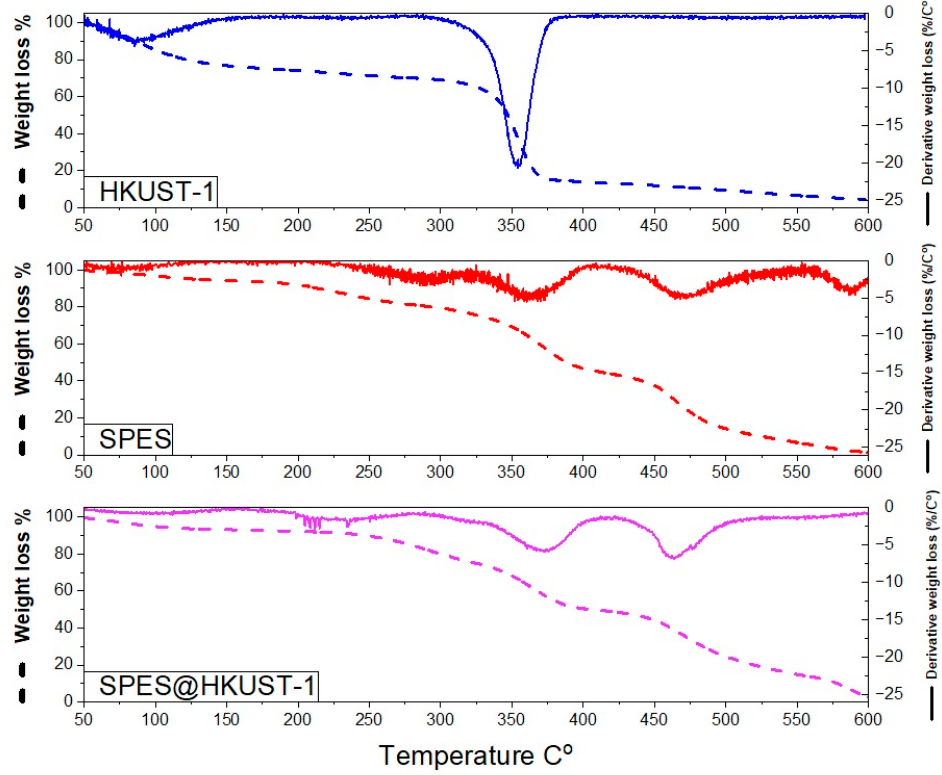
Figure 5. TGA and DTG curves for the powder of the HKUST-1, the SPES membranes, and the SPES@HKUST-1 membranes under air atmosphere.